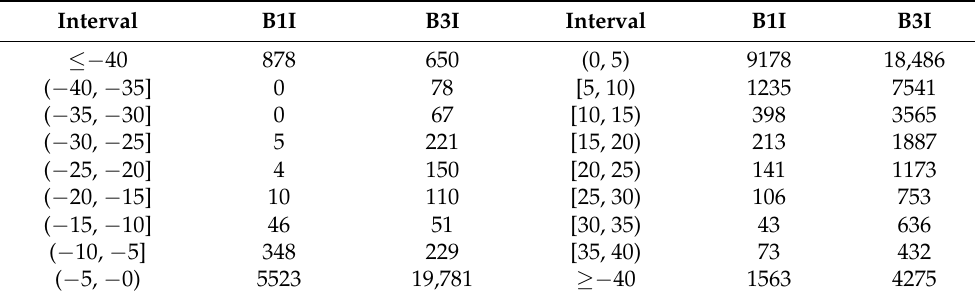
Figure 10. The fitting envelop curve of the cycle-slips histogram with the mixture of Gaussian distribution. Table 3. Size of cycle slips statistics.